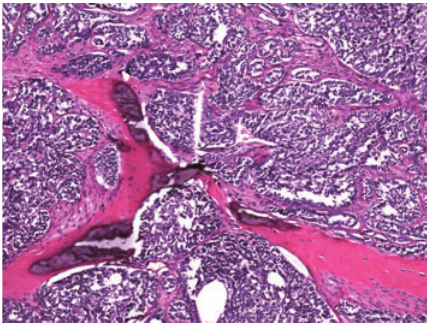
Figure 5: Histological preparation (100x magnification, H-E stain) showing the tumour, which infiltrates between preexisting bone-trabeculae. The tumour cells have scanty cytoplasm and a chromatin rich nucleus and are similar to basaloid cells. The tumour shows solid areas and tubular structures here. Fibrous septae cross the basaloid cell aggregates.